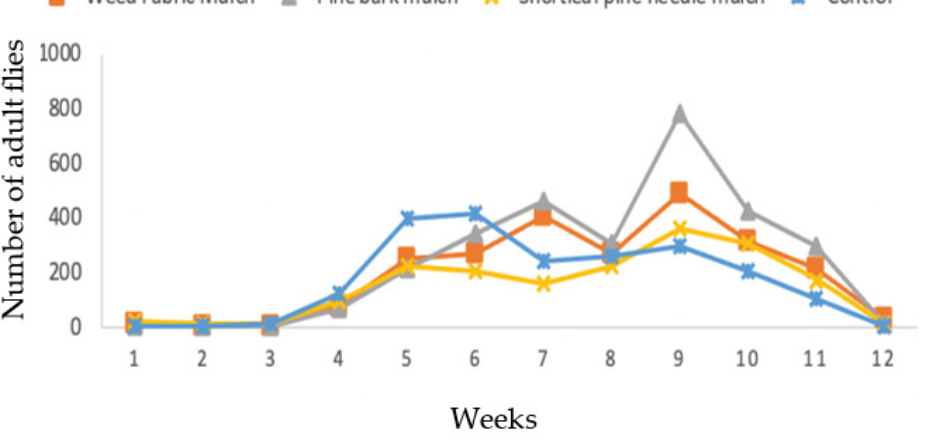
Figure 5. Effects of three mulching practices in comparison to unmulched control on the capture of D. suzukii in blueberry field using Scentry ® trap in 2017.